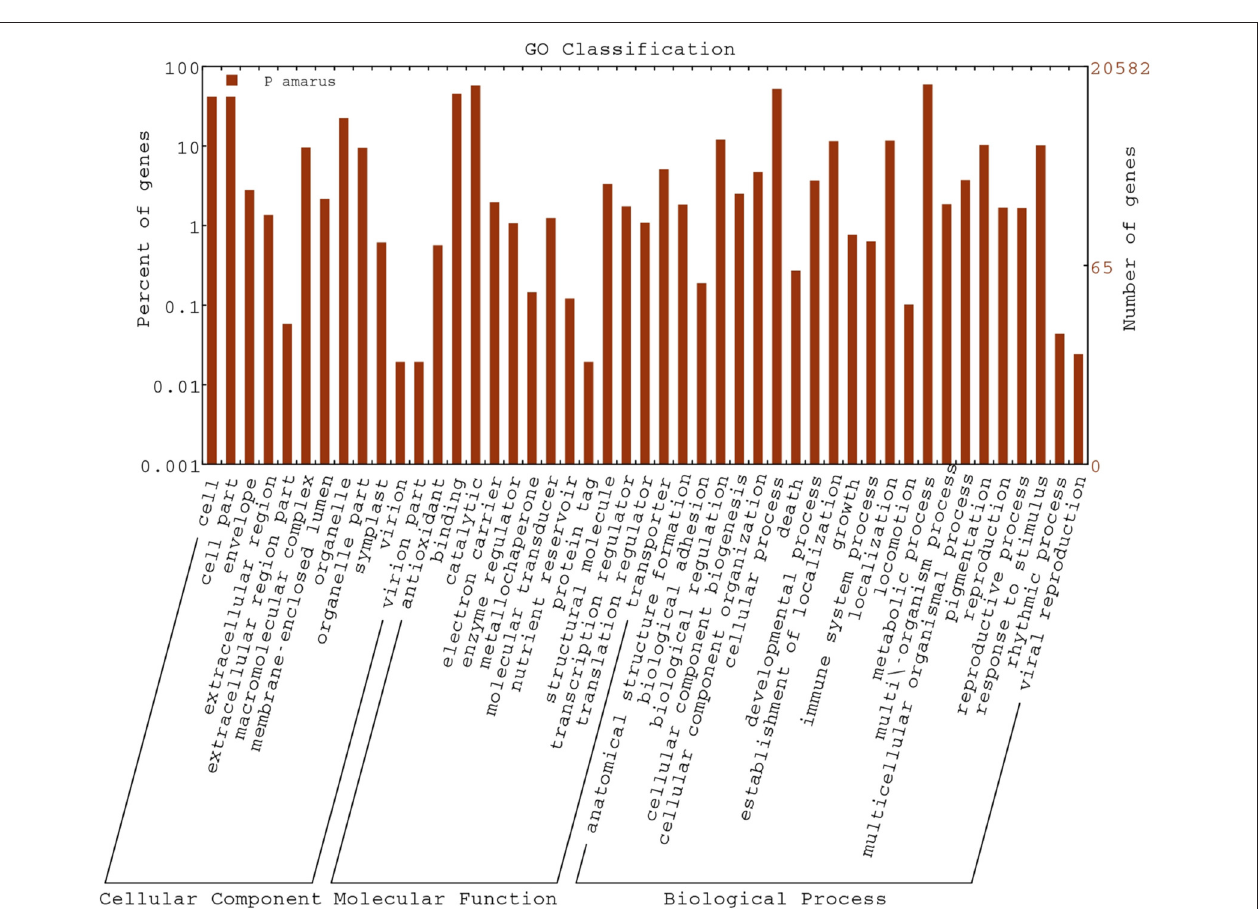
FIGURE 3 | GO functional classifications using WEGO.